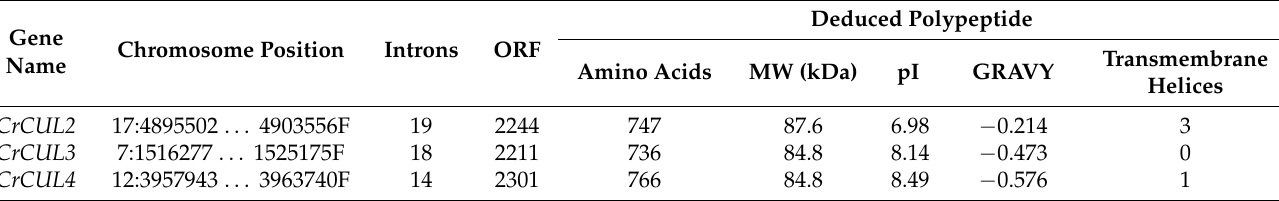
Table 1. List of three CrCUL genes identified in C. reinhardtii and their sequence characteristics.